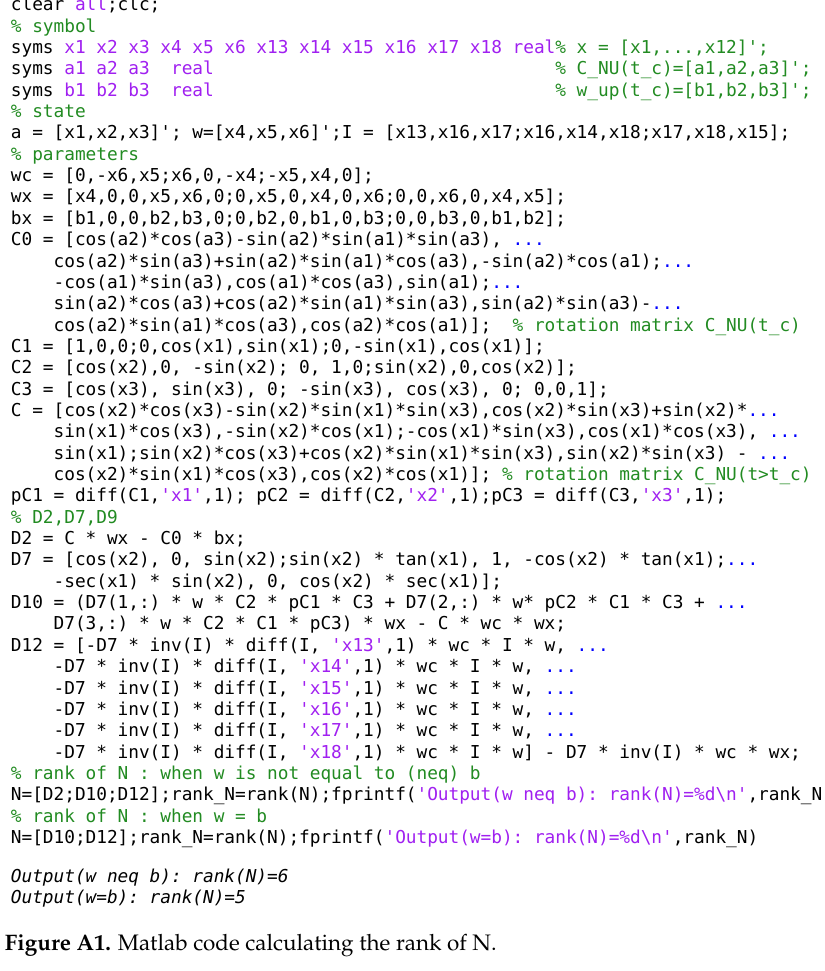
Figure A1. Matlab code calculating the rank of